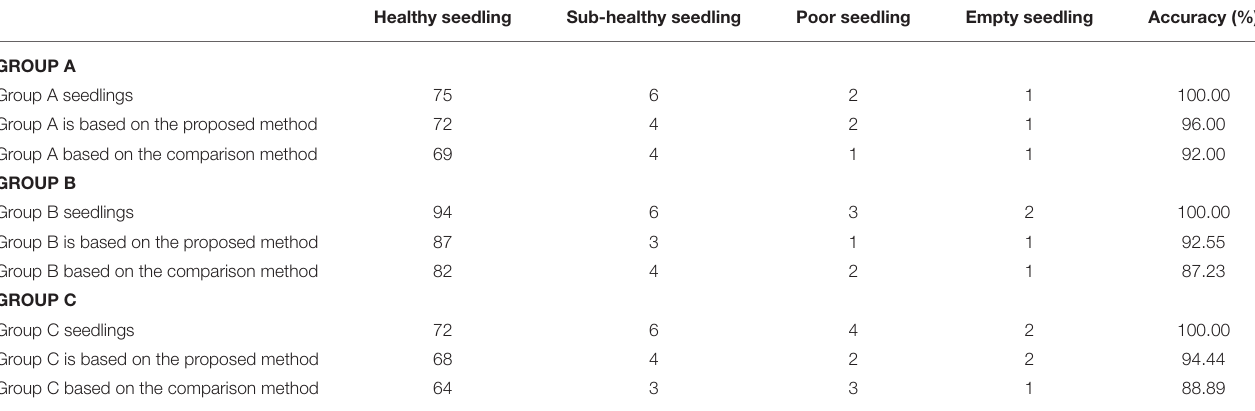
TABLE 2 | Identification results and accuracy.